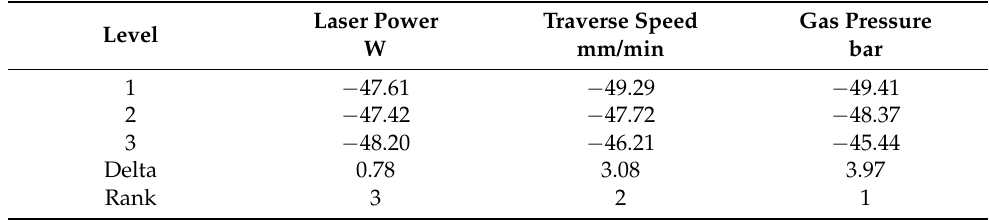
Table 12. S / N ratio smaller-is-better response table of input cutting parameters of 6 mm thick SPF- UPE.